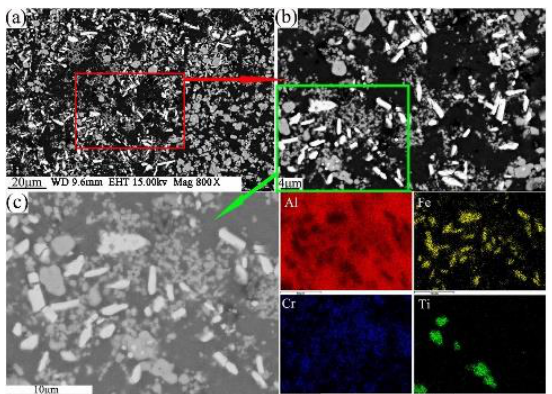
Figure 11. FESEM/BSE morphology of sintered sample with compaction velocity 9.4 ms − 1 ( a , b ); Al, Fe, Cr, and Ti element EDS mapping ( c ).